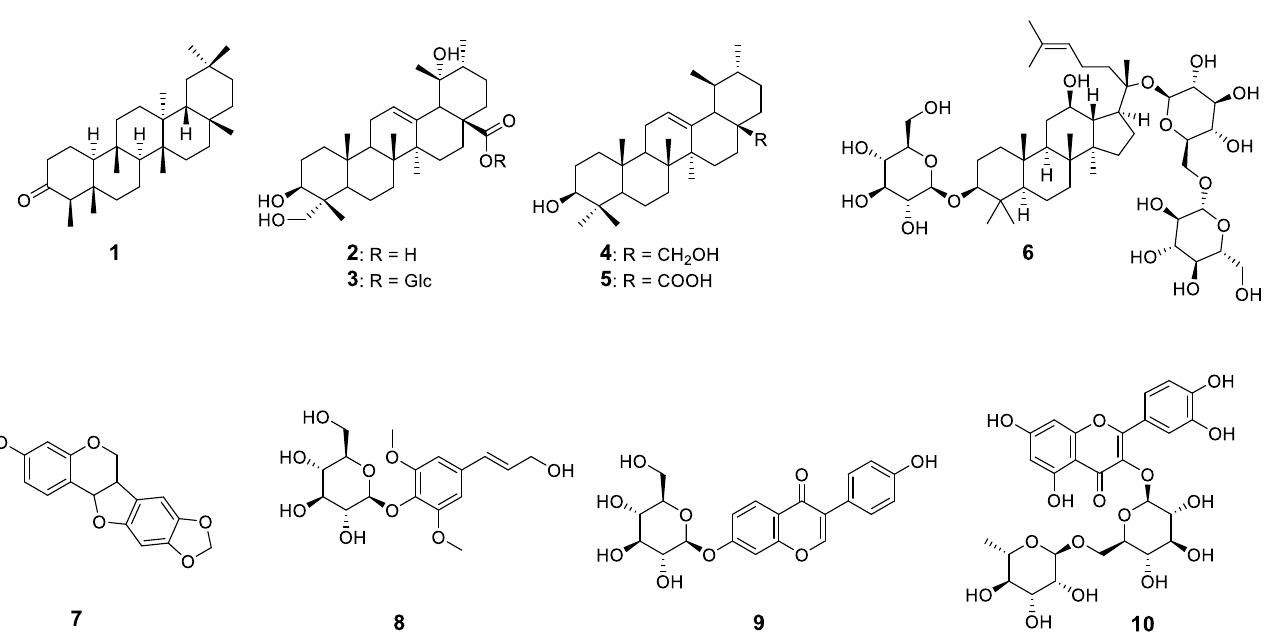
Figure 1. Chemical structures of the isolated compounds from the roots of Milletia speciosa . Compounds — 1 : friedelin; 2 : rotundic acid; 3 : pedunculoside; 4 : uvaol; 5 : ursolic acid; 6 : gypenoside XVII; 7 : pterocarpin; 8 : syringin; 9 : daidzin; 10 :